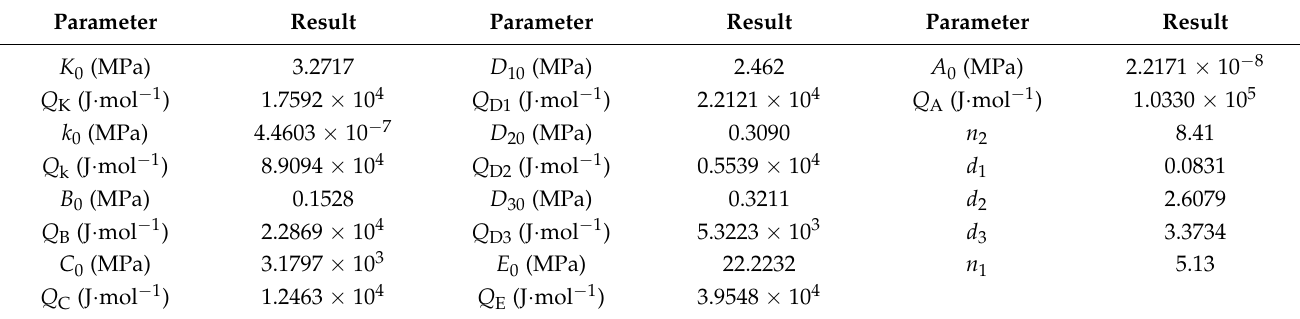
Table 2. Parameters in the constitutive model of 7075 aluminum alloy.